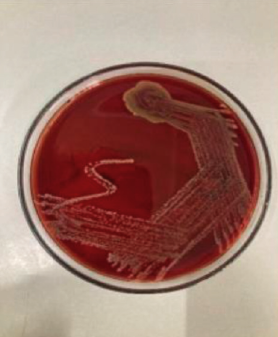
Figure 2: Whitish colonies of Staphylococcus aureus in a 5% sheep blood agar plate.